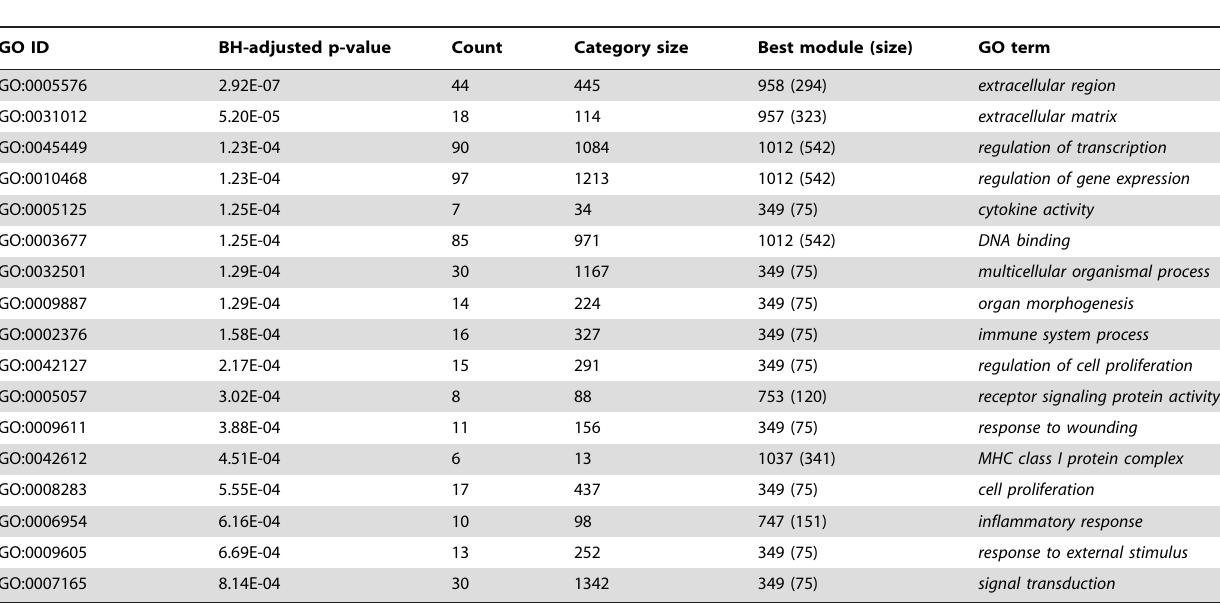
Table 2. Summary of GO terms and KEGG pathways enriched in the dysregulated transcription modules, M1 modular analysis.